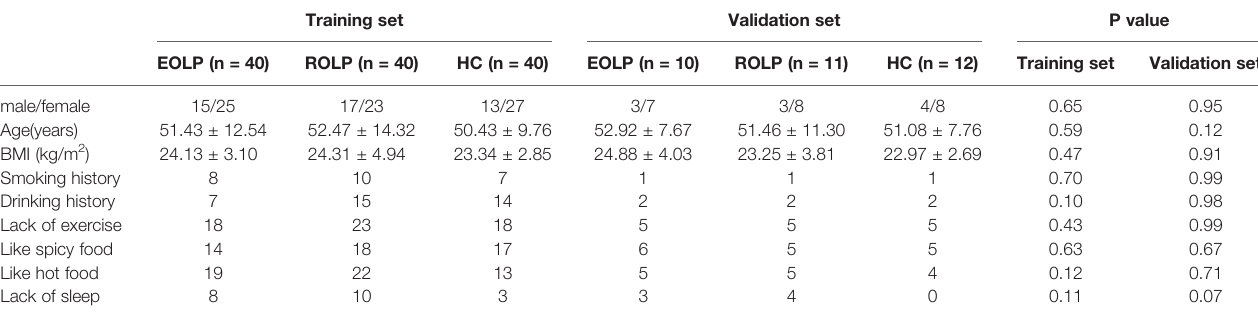
TABLE 1 | The baseline characteristics of participants. Training set Validation set